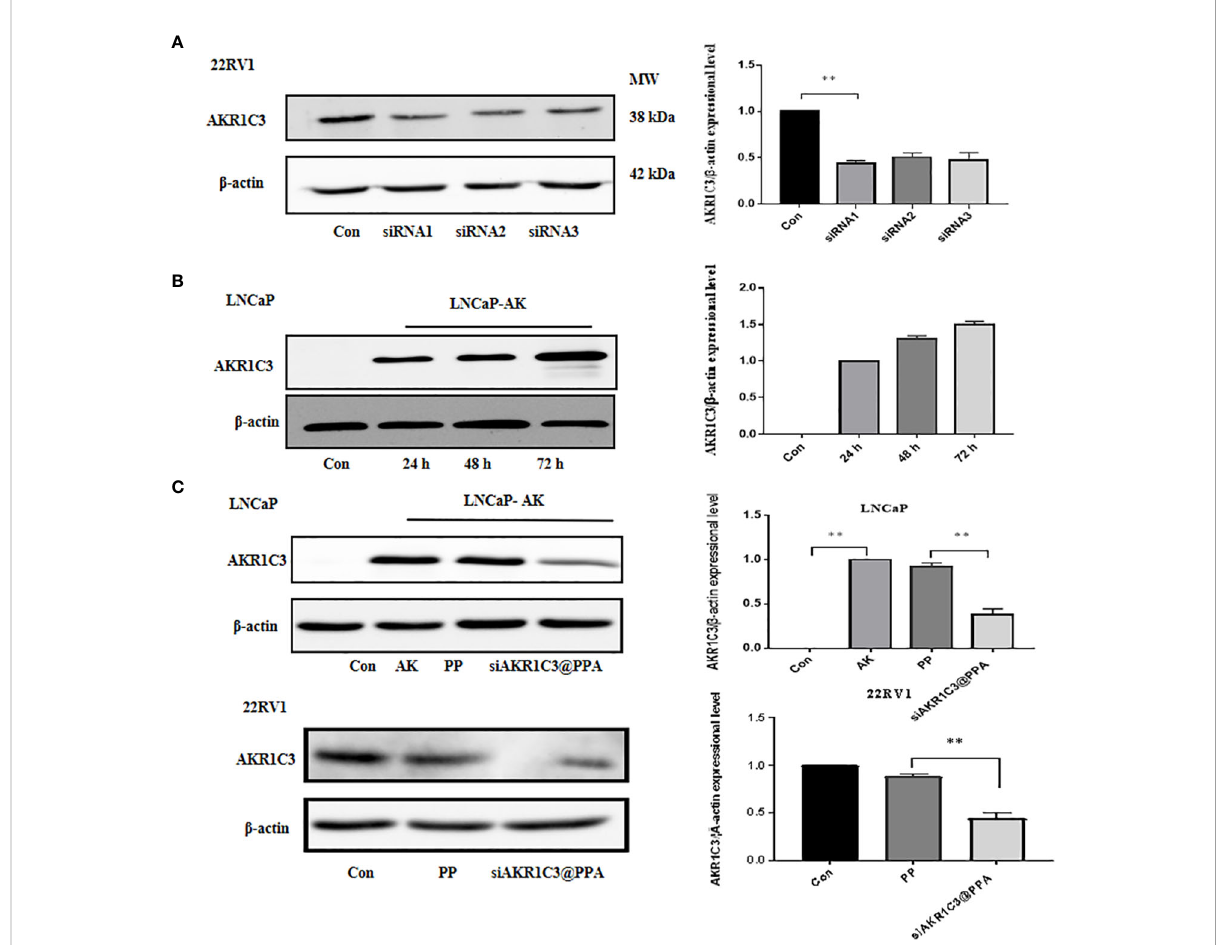
FIGURE 4 siAKR1C3@PPA transfection decreased AKR1C3 protein expression levels. (A) Effectiveness of siAKR1C3 transfection in 22RV1 cells. (B) Effectiveness of AKR1C3 plasmid transfection in LNCaP cells. (C) siAKR1C3@PPA reduced AKR1C3 protein expression in LNCaP-AKR1C3 and 22RV1 cells. Data are presented as the mean ± SD, n=3; **P <